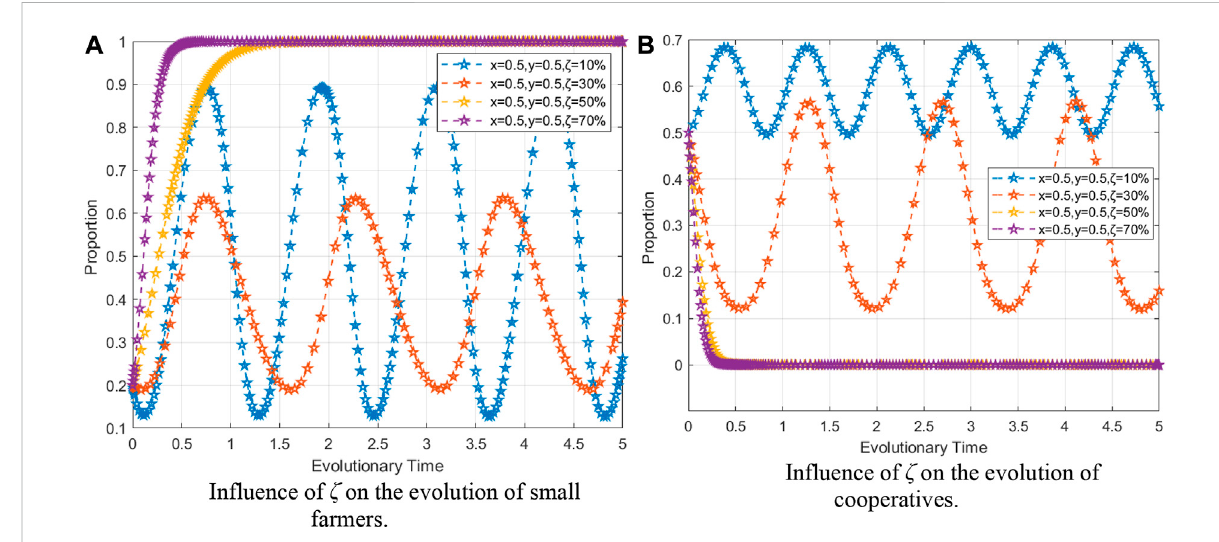
FIGURE 11 (A) In fl uence of ζ on the evolution of small farmers. (B) In fl uence of ζ on the evolution of cooperatives.